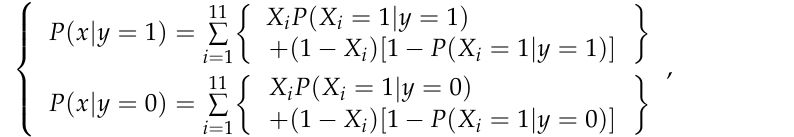
Table 3. The theoretical fault value and output value of the network.